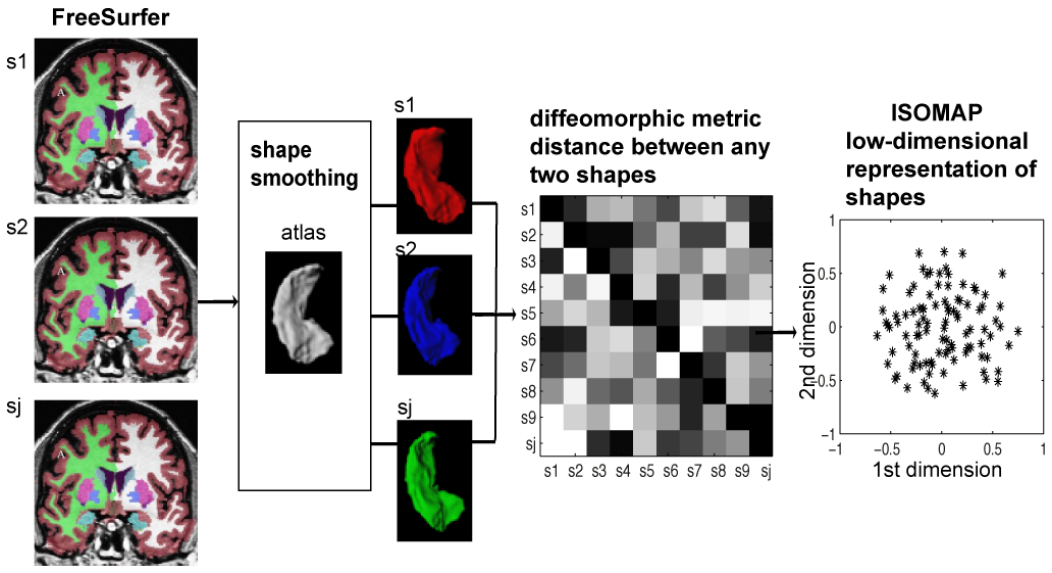
Figure 1. Schematic of MRI data processing.